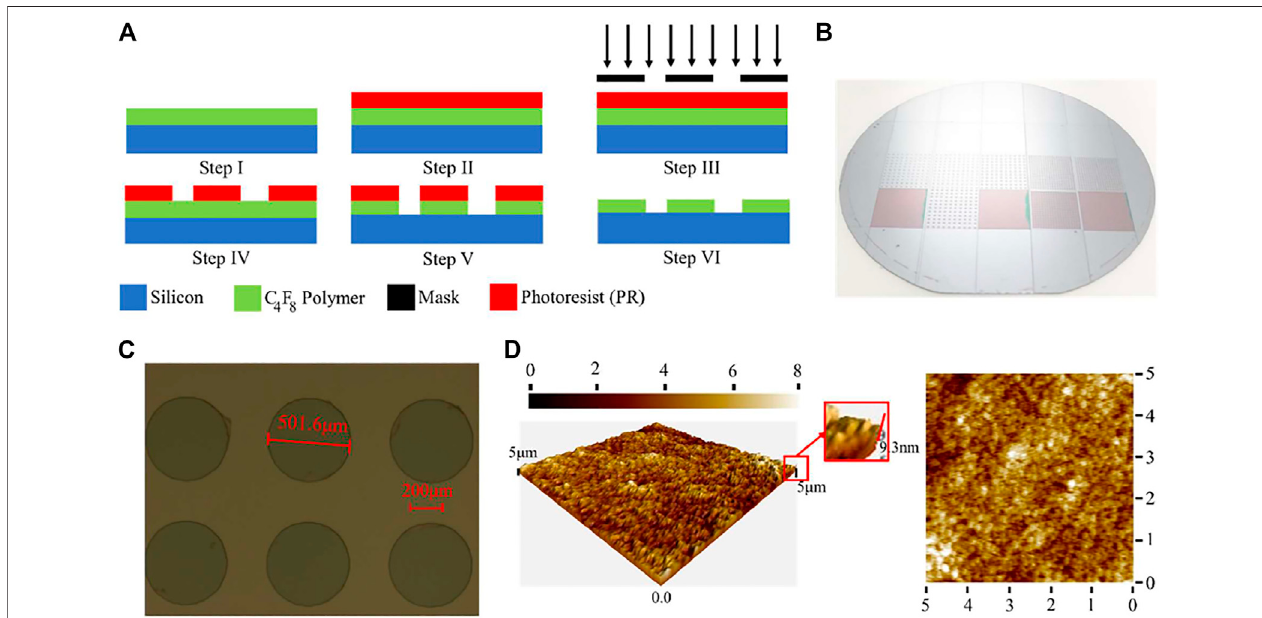
FIGURE 3 | (A) schematic of the fabrication process, (B) microscopic view of the fabricated surfaces, (C) macroscopic representation of the C 4 F 8 islands on the silicon surface, (D) AFM images of the coated C 4 F 8 .